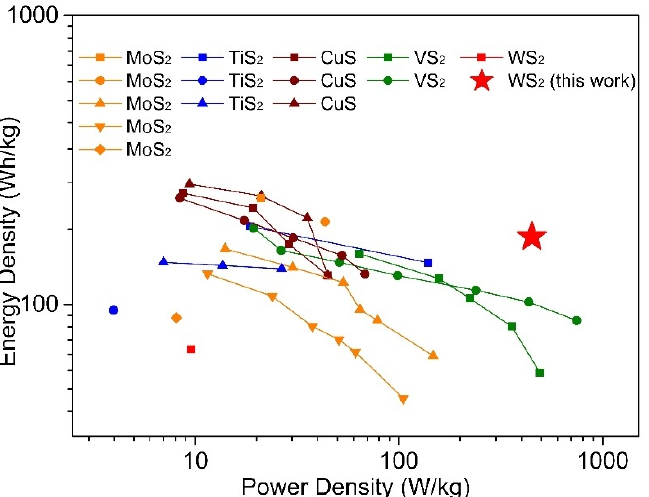
Figure 5. Ragone plots for magnesium batteries with different cathodes (by cathode mass). The data about WS 2 and other metal sulfide cathode materials for magnesium batteries are taken from previous studies reported in the references